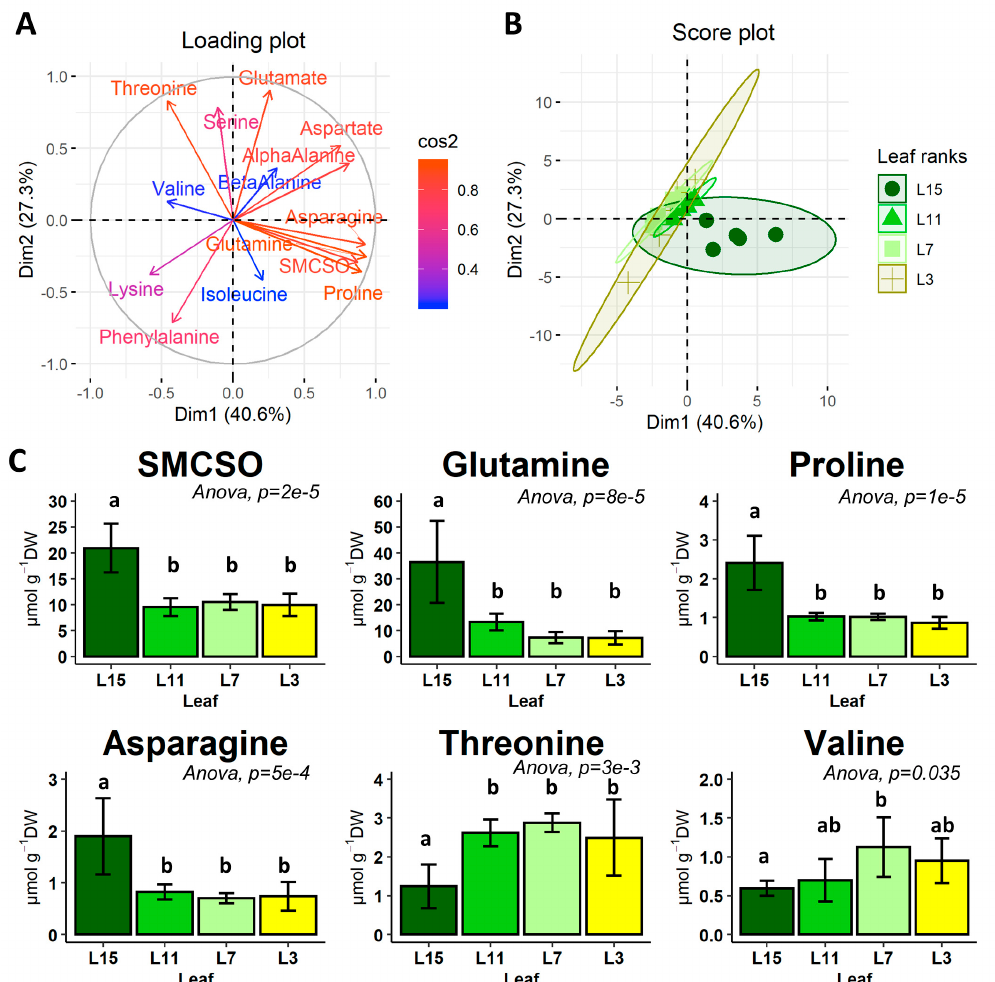
Figure 2. Principal Component Analysis of free amino acid contents from four leaf ranks (L15, L11, L7, L3) of oilseed rape plants grown at the vegetative stage. ( A ) Loading plot with Pearson correlation coefficients for each amino acid along the two major axis of the PCA; ( B ) Score plot of leaf groups along the two major axes of the PCA with 95% confidence ellipses; ( C ) Content of amino acids differentiating the leaf ranks. Values are the mean ± SD of 5 independent biological replicates. Di ff erent letters indicate groups of mean values that are significantly di ff erent between the di ff erent leaf ranks (ANOVA-Tukey HSD, p -value < 0.05). PCA analysis was performed on amino acids showing a normal distribution of their values (denoted in bold in the complete dataset available in Supplementary Table